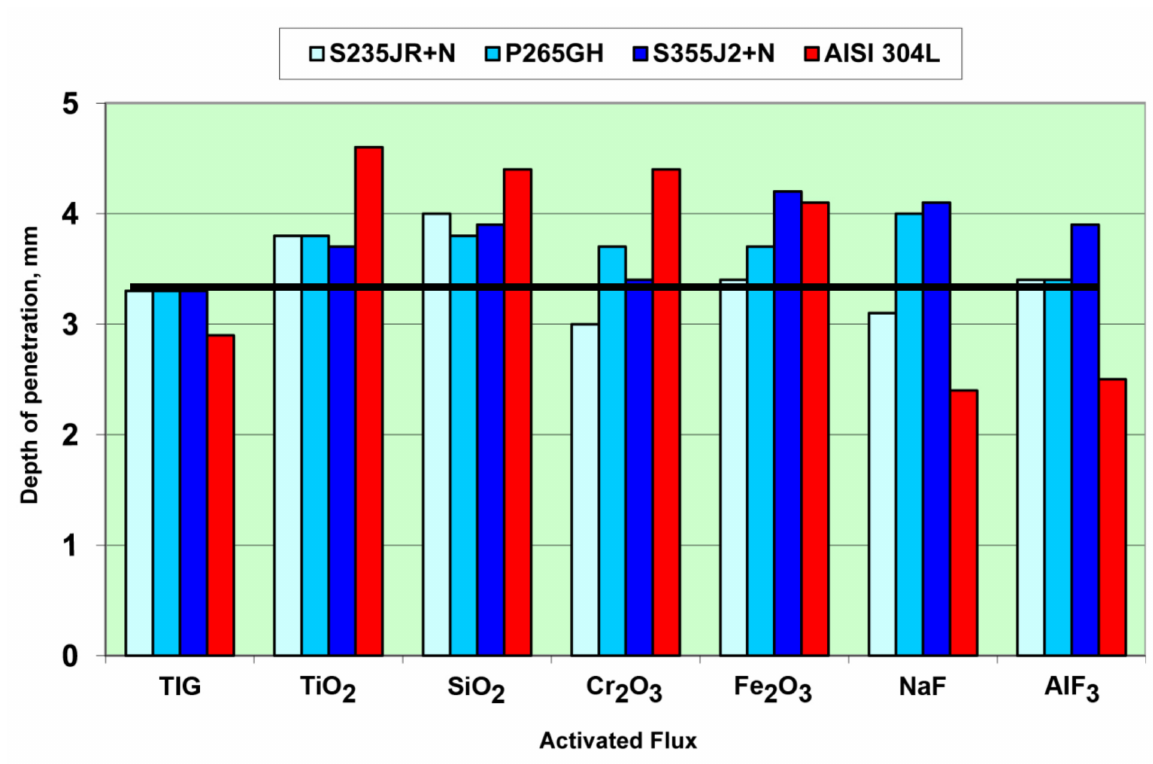
Figure 6. Correlation between the depth of penetration and the types of activated fluxes.